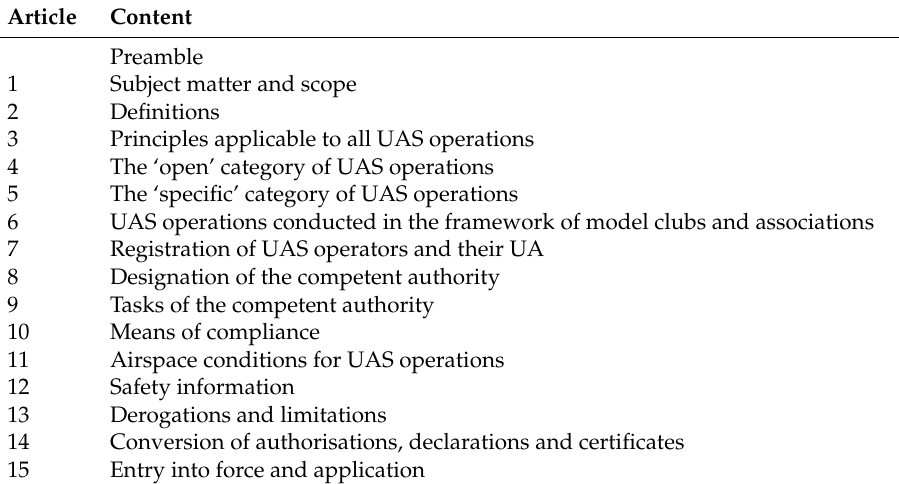
Table 2. Content of the UAS Operations Regulation [7].